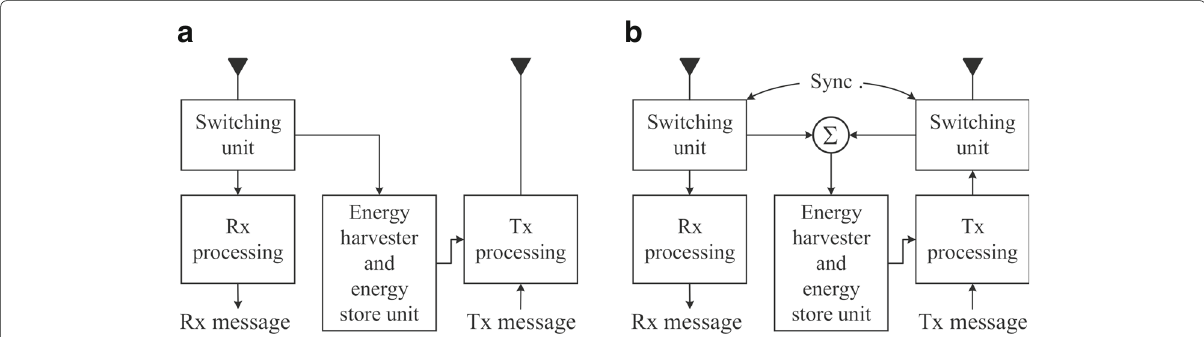
Fig. 2 Receiver architecture of relay with energy harvesting. a Relay node with single antenna EH. b Relay node with dual antennas